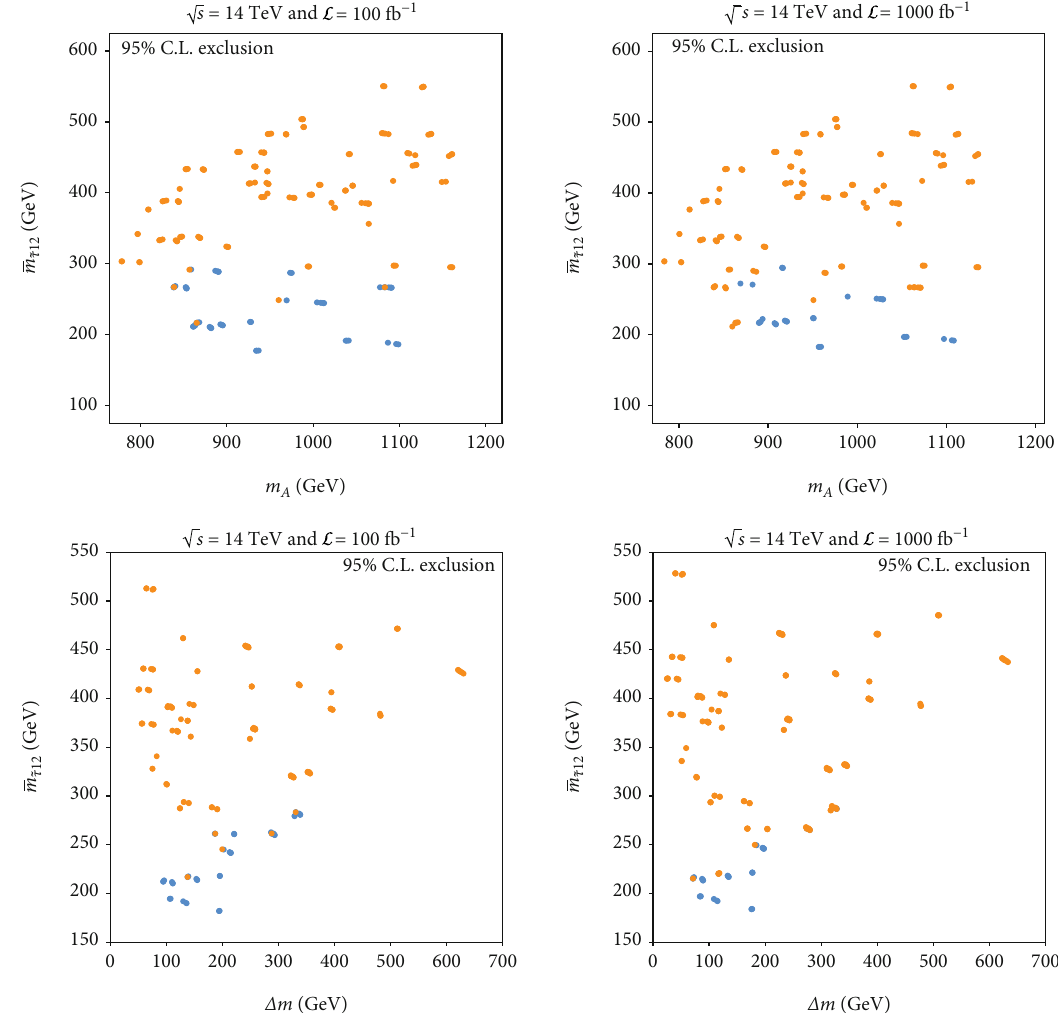
(cid:2) plane (a, b) and ½ Δ m , (cid:2) m , (cid:2) m ~ τ A 12